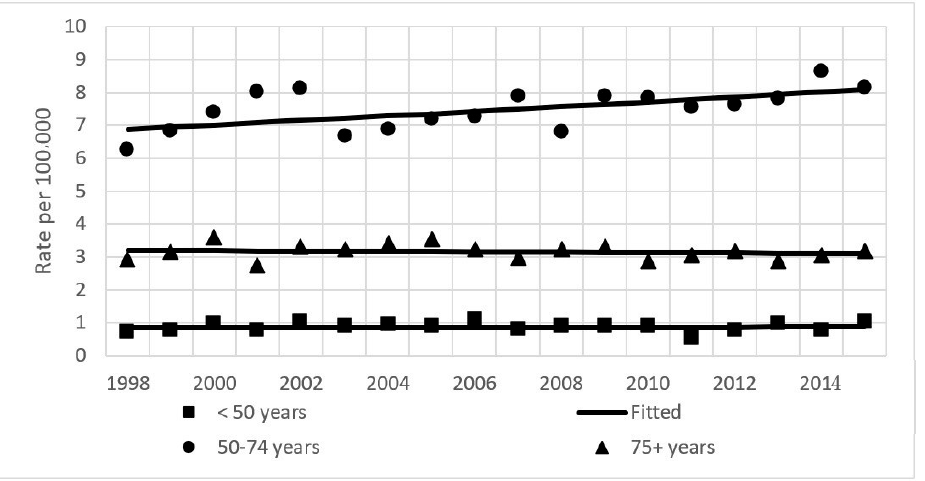
Figure 3. Age-standardized incidence rates of pancreatic cancer by age group in Lithuania from 1998–2015. Both